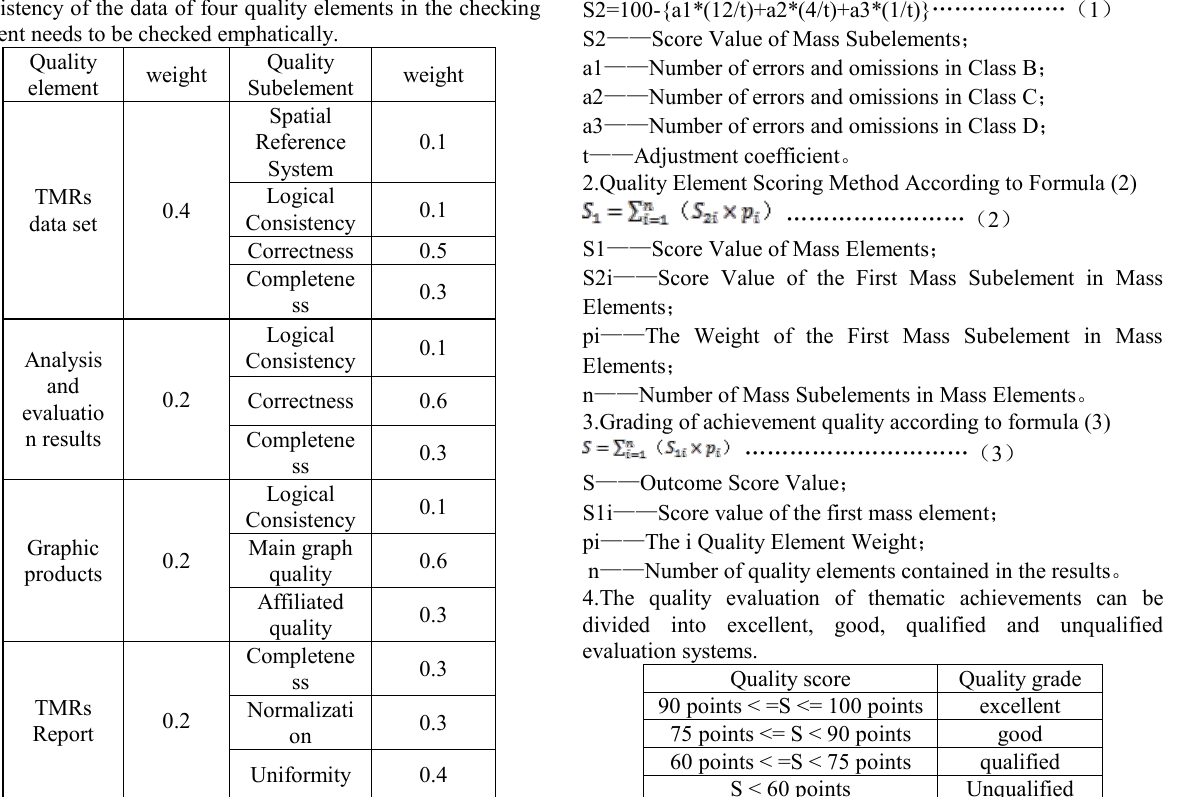
Table 2. Quality Elements and Weights of Thematic Outcomes Table 4 Grade of Quality Assessment of Thematic